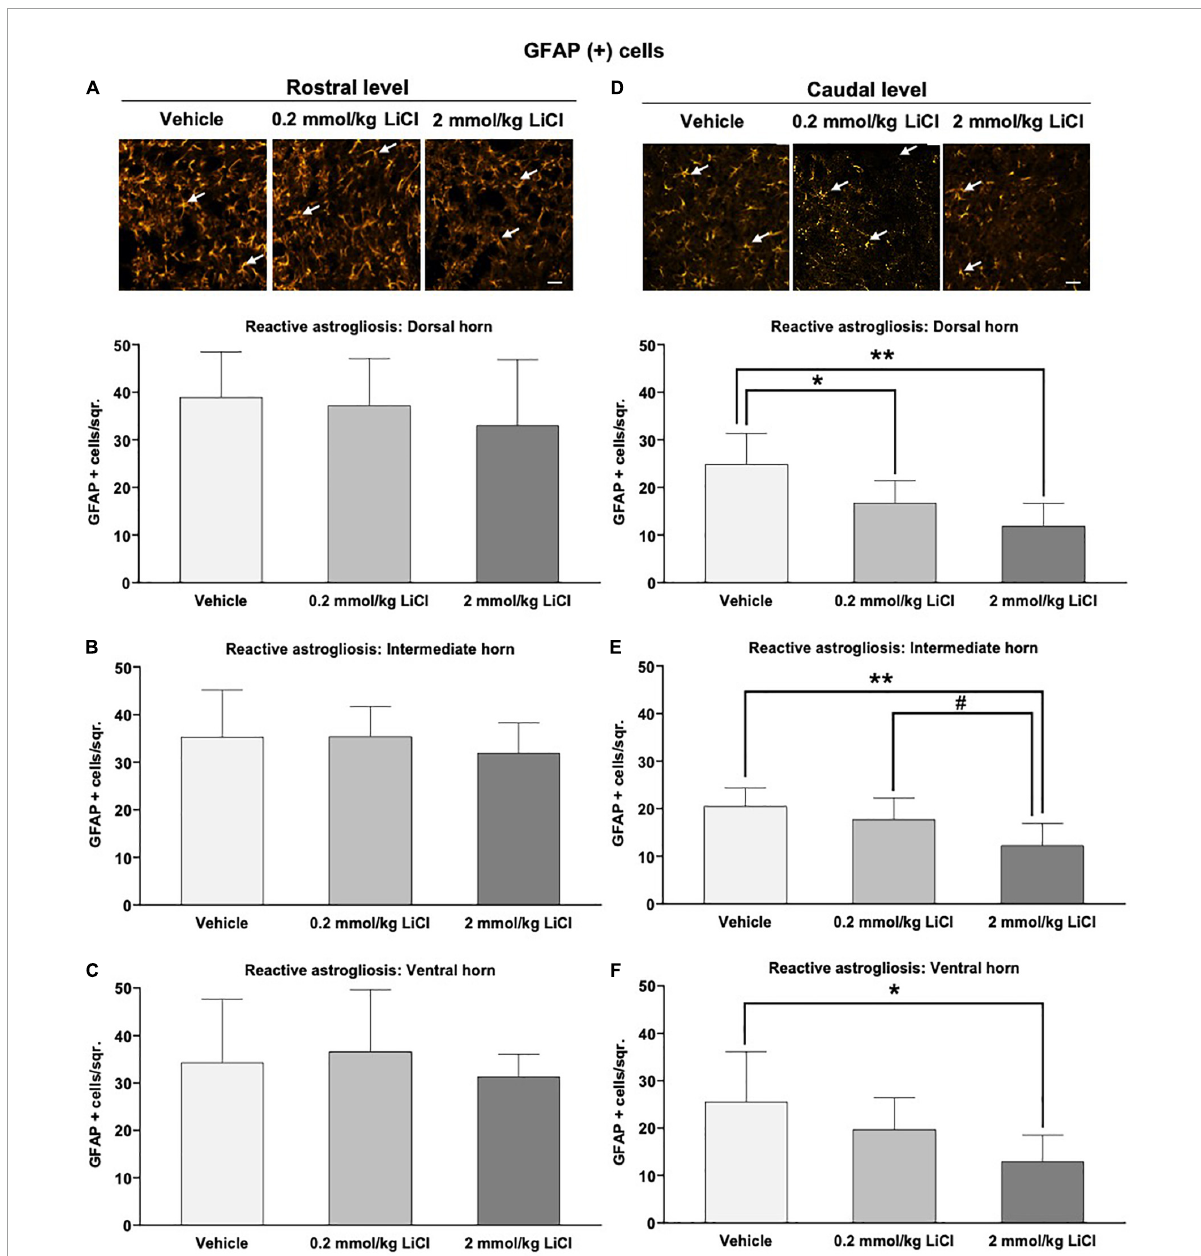
FIGURE5 Low-dose and high-dose lithium reduces reactive astrogliosis in the gray matter caudal to the hemitransection. Reactive astrogliosis in (A,D) the dorsal horn, (B,E) the intermediate horn, and (C,F) the ventral horn of the spinal cord assessed by GFAP immunohistochemistry at (A–C) the rostrocaudal level above the hemitransection (“Rostral level”) and (D–F) the rostrocaudal level below the hemitransection (“Caudal level”) of SCI mice, which were treated with vehicle or lithium (0.2 or 2 mmol/kg/day) for 56 days. Representative GFAP stainings are also shown. Data are mean ± SD values ( n = 16 animals/group). * p < 0.05/** p < 0.01 for 0.2 mmol/kg or 2 mmol/kg LiCl vs. vehicle; # p < 0.05 for 2 mmol/kg LiCl vs. 0.2 mmol/kg LiCl. Please note that white arrows indicate representative glia. Scale bars, 50 µ